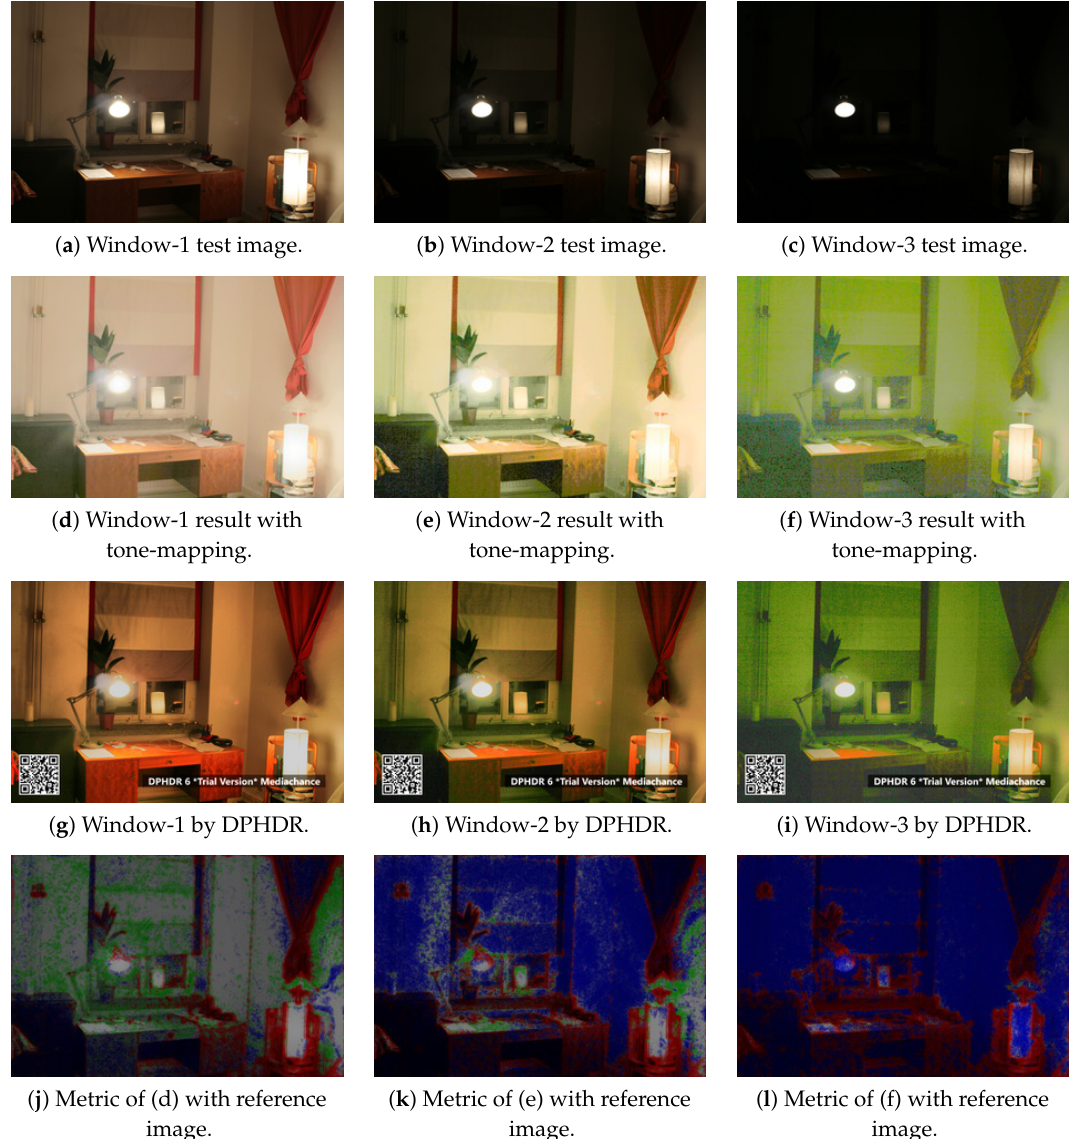
Figure 11. The results of Window series images, ( a – c ) are the input images, ( d – f ) are the outputs with tone-mapping, ( g – i ) are the results from Dynamic Photo HDR-6 for comparison, and ( j – l ) are the prediction of the dynamic range independent metric by Image Quality Assessment [35] of the Window series tone-mapping results.